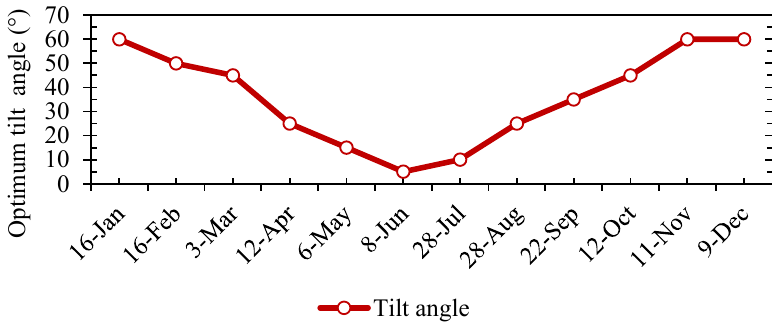
Figure 3. Optimum tilt angle for the central part of the CPC by month.